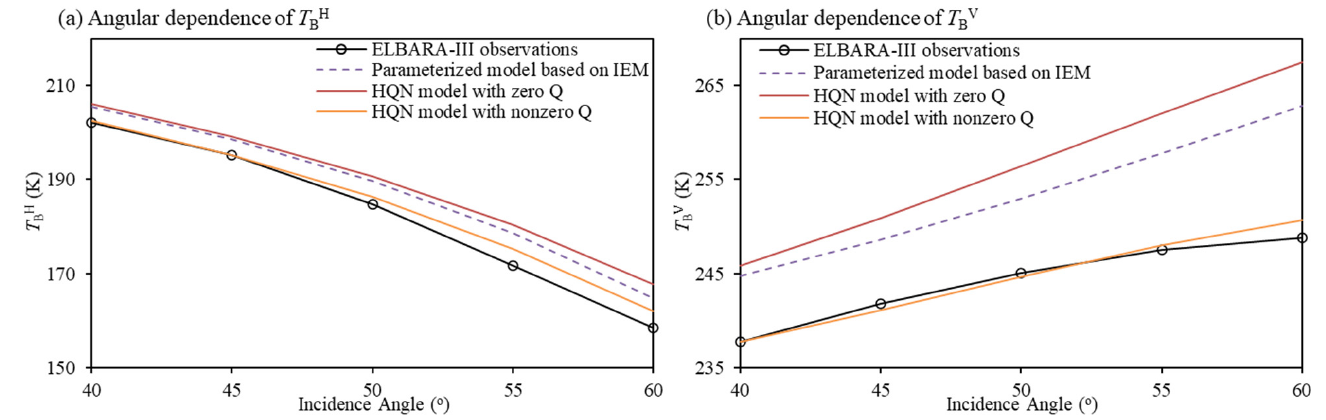
Figure 3. Angular dependence of ELBARA-III T B p observations and corresponding simulations produced by the h-Q-N model with/without a zero Q value as well as the parameterized model developed by Shi et al. [57] based on the IEM simulations. The figure is modified from Wu and Zheng [57].